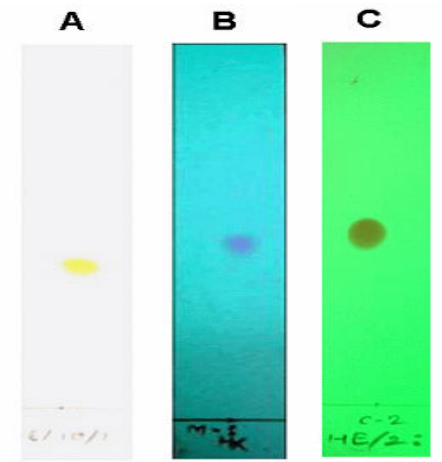
Figure 1: Demonstration of isolation pattern of pure compounds on TLC plate using iodine (A), UV-detection (B) and spray reagent